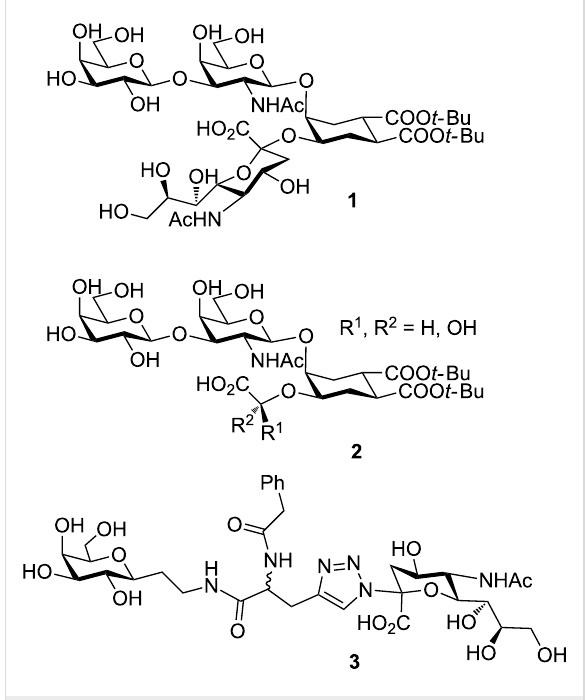
Figure 3: Bernardi and co-workers’ designed oligosaccharide mimetics of GM 1 .